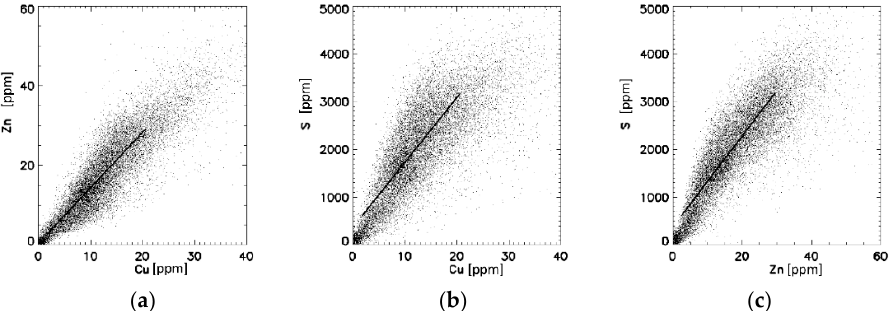
Figure 3. Correlations between elements in ppm for C-GB (Figure 2). ( a ) Cu:Zn = 1.28; r s = 0.92. ( b ) S:Cu = 70; r s = 0.92. ( c ) Correlations between S:Zn = 79, r s = 0.88. For all p < 0.001.